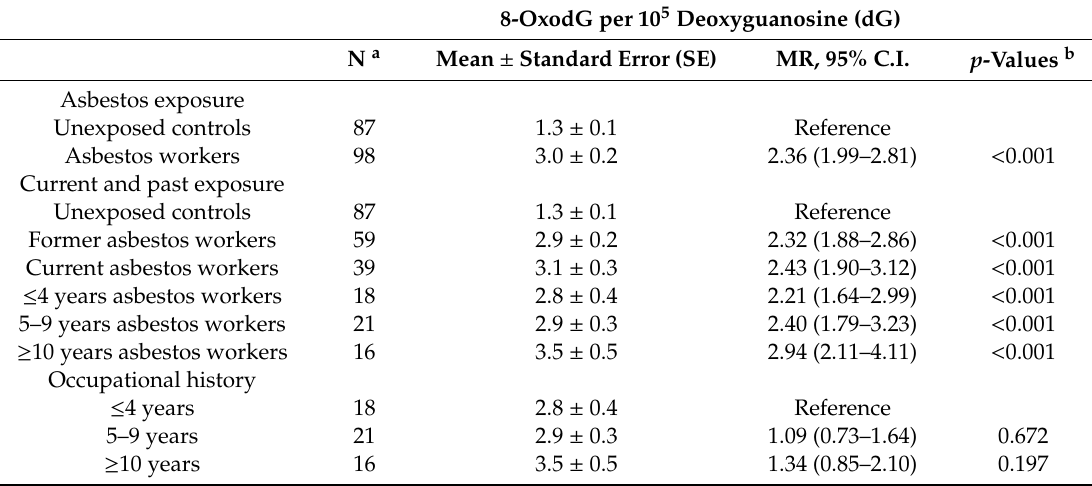
Table 2. Mean levels of 8-hydroxy-2 (cid:48) -deoxyguanosine (8-oxodG) in study subjects considering asbestos exposure, occupational history and